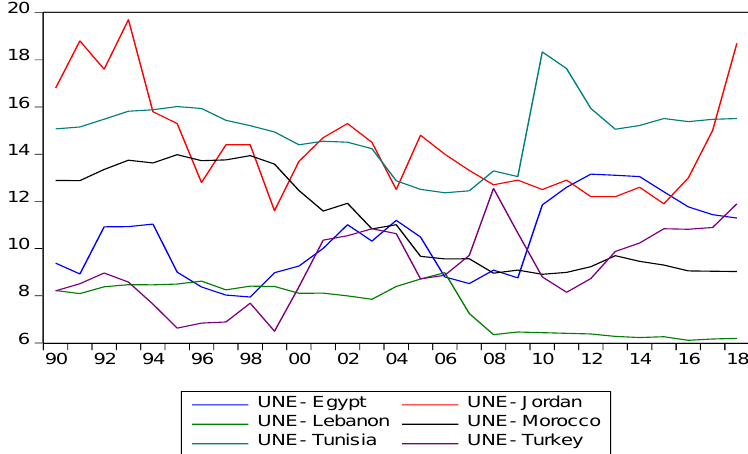
Figure 2. The evolution of unemployment in the six analyzed countries.